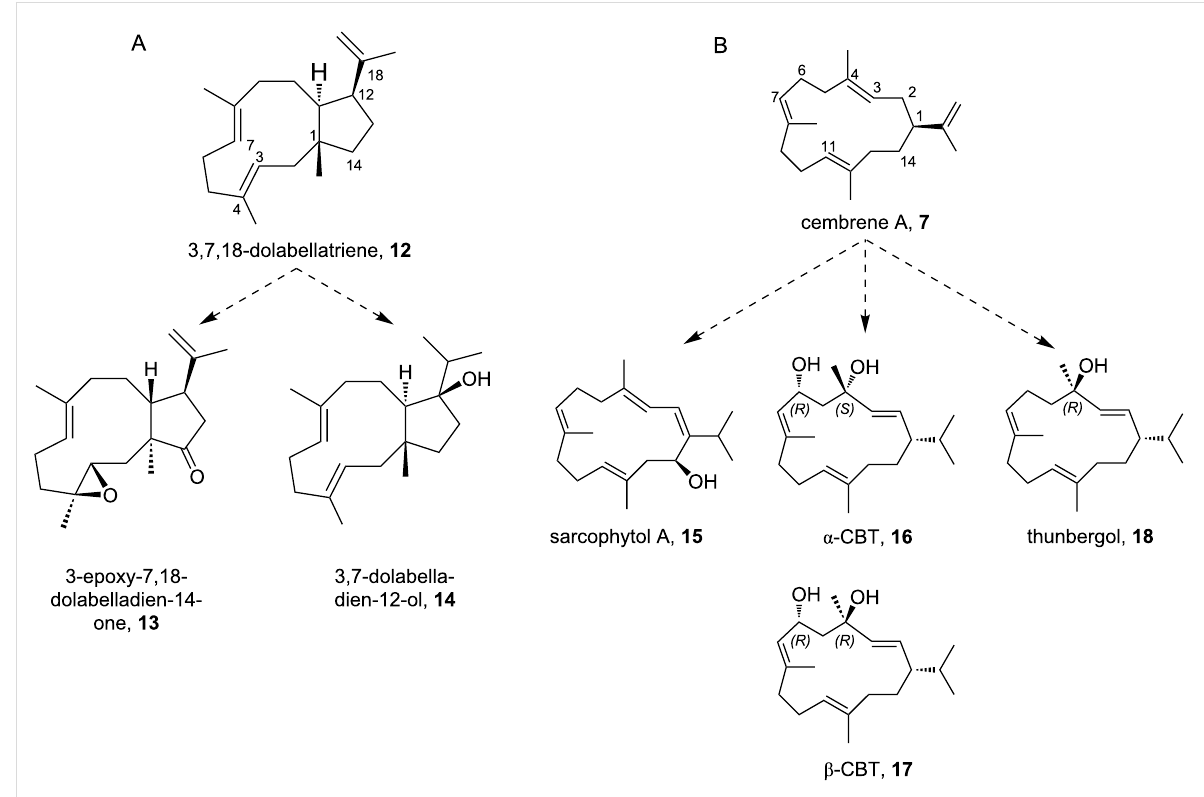
Scheme 3: Variants of CotB2 open the route to a novel product portfolio with altered cyclic carbon skeletons, which can be converted into bioactive compounds by chemo-enzymatic methodologies. Modification descriptions are composed according to the atom numbering. (A) Lead structure for the dolabellane derivatives is 3,7,18-dolabellatriene ( 12 ) and (B) cembrene A ( 7 ) for the cembranoid